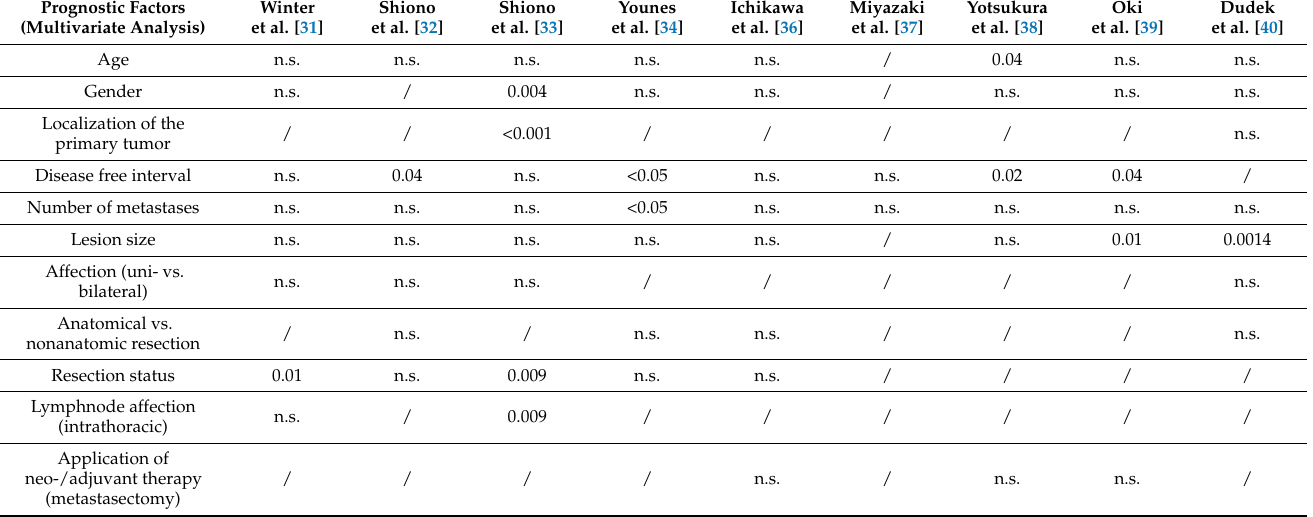
Table 3. Multinomial regression